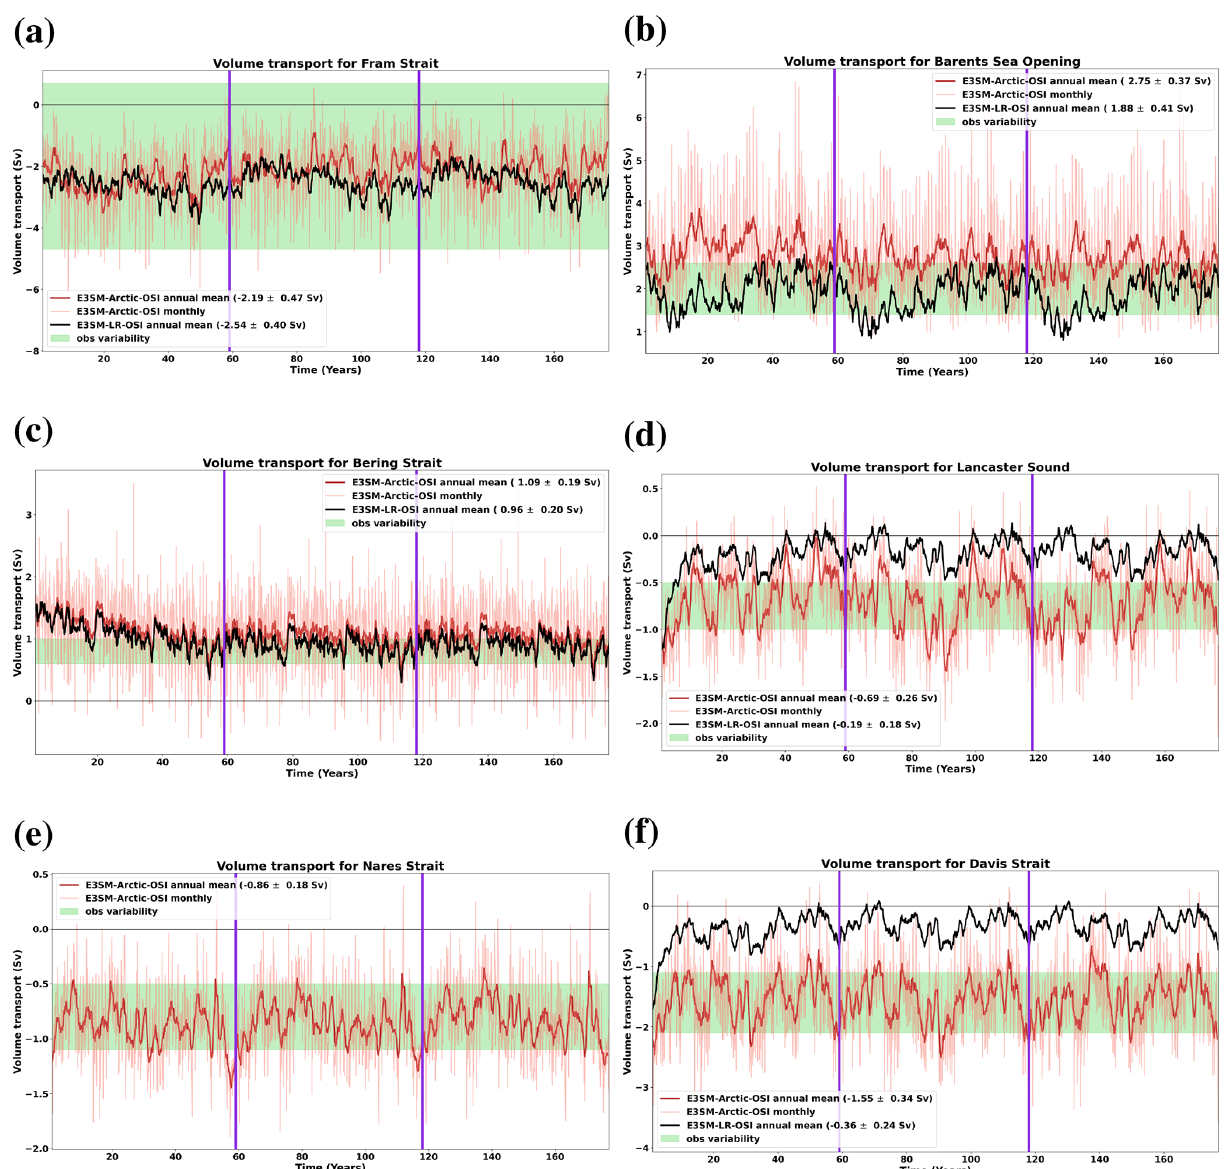
Figure 7. Time series of the 1-year running average net volume transport for the five Arctic gateways (Fram Strait, BSO, Bering Strait, Lancaster Sound, and Nares Strait) and Davis Strait, from E3SM-Arctic-OSI (dark red lines) and E3SM-LR-OSI (black lines). The light red lines show E3SM-Arctic-OSI monthly values; the corresponding E3SM-LR-OSI monthly values are not shown for clarity. The vertical purple lines mark the transition between JRA cycles. The numbers shown in the insets are the mean and standard deviations of the annual model values, computed over the full time series. Transect location is displayed in Fig. 1c. Observational values are − 2 ± 2 . 7Sv for Fram Strait (Schauer et al., 2008), 2 ± 0 . 6Sv for the BSO (Skagseth et al., 2008; Smedsrud et al., 2013), 0 . 8 ± 0 . 2Sv for the Bering Strait (Woodgate and Aagaard, 2005), − 0 . 75 ± 0 . 25Sv for the Lancaster Sound (Prinsenberg and Hamilton, 2005), between − 0 . 5 and − 1 . 1Sv for the Nares Strait (Münchow, 2016), and − 1 . 6 ± 0 . 5Sv for the Davis Strait (Curry et al.,